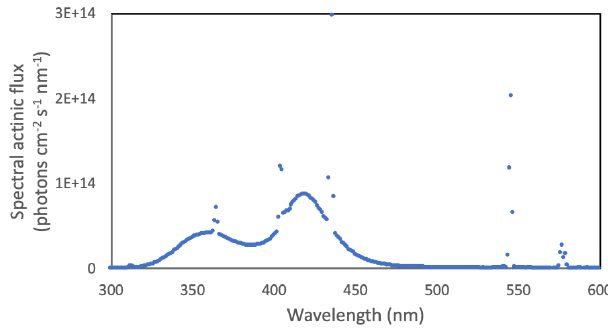
Figure A1. Spectral actinic flux versus wavelengths of the UV light source used in our